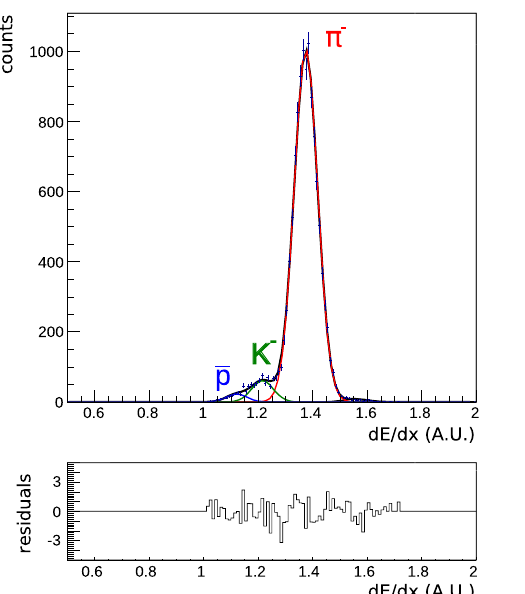
at 150 A GeV / c . As expected, the values of x i increase